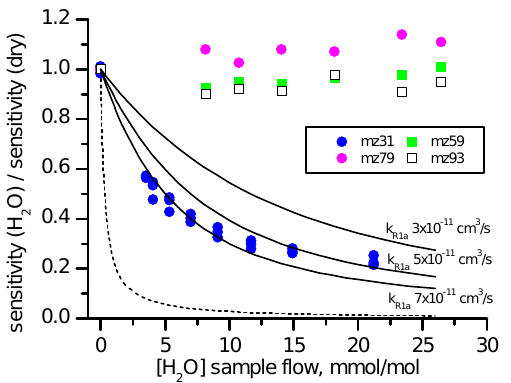
Fig. 6. Intercomparison of formaldehyde detection by PTR-MS and the Hantzsch monitor for the Egbert 2007 dataset. Humid- ity correction of PTR-MS data was done using reaction constant k R1a =6 × 10 − 11 cm 3